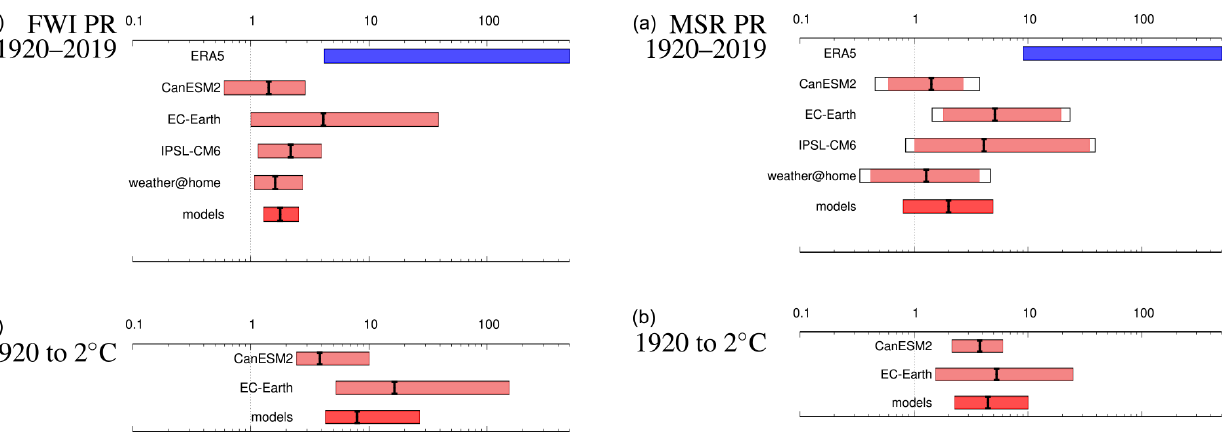
Figure 7. As Fig. 6 but for the monthly severity rating (MSR).